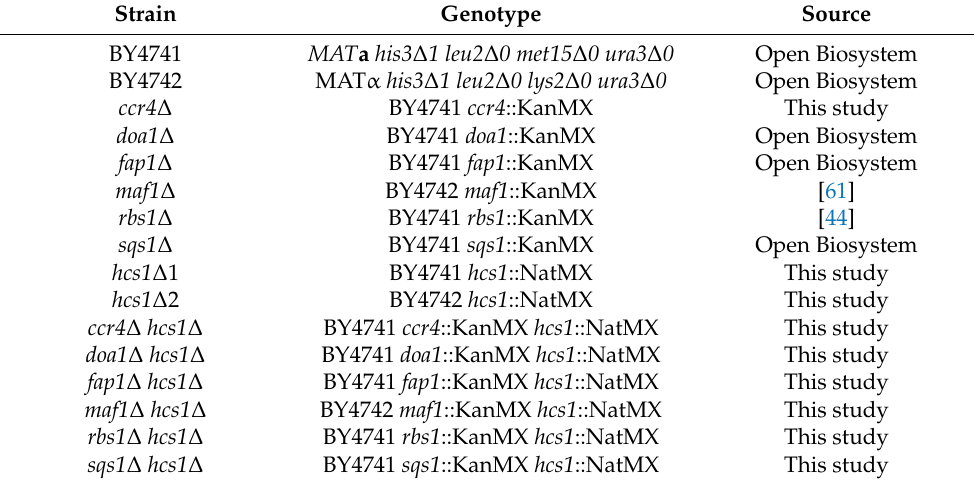
Table 2. S. cerevisiae strains used in this